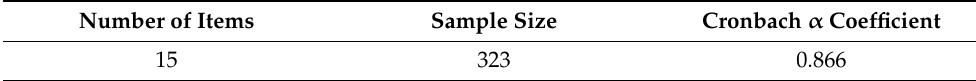
Table 3. Cronbach reliability analysis—simplified format.